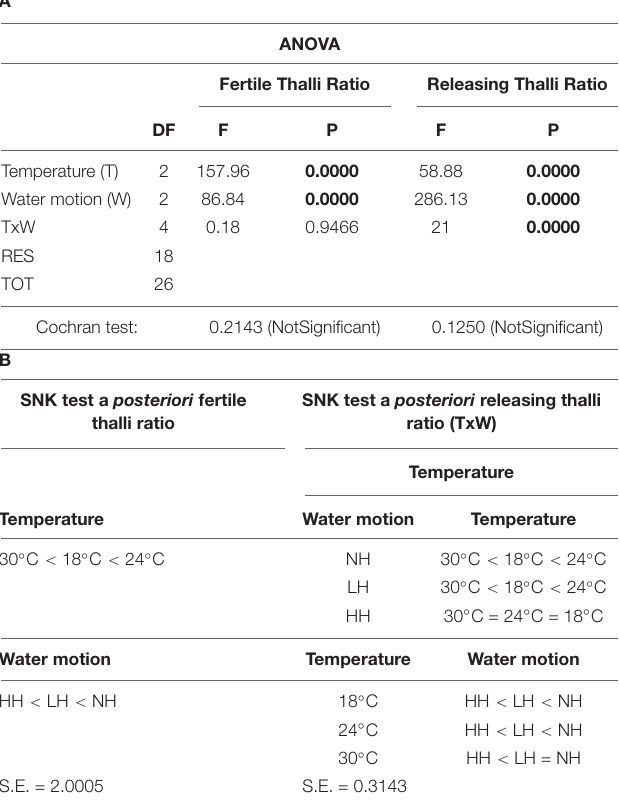
TABLE 2 | (A) Results of the ANOVAs on data regarding the FT/TT and the releasing thalli (RT)/FT ratios for each treatment: Temperature (T): 18 vs. 24